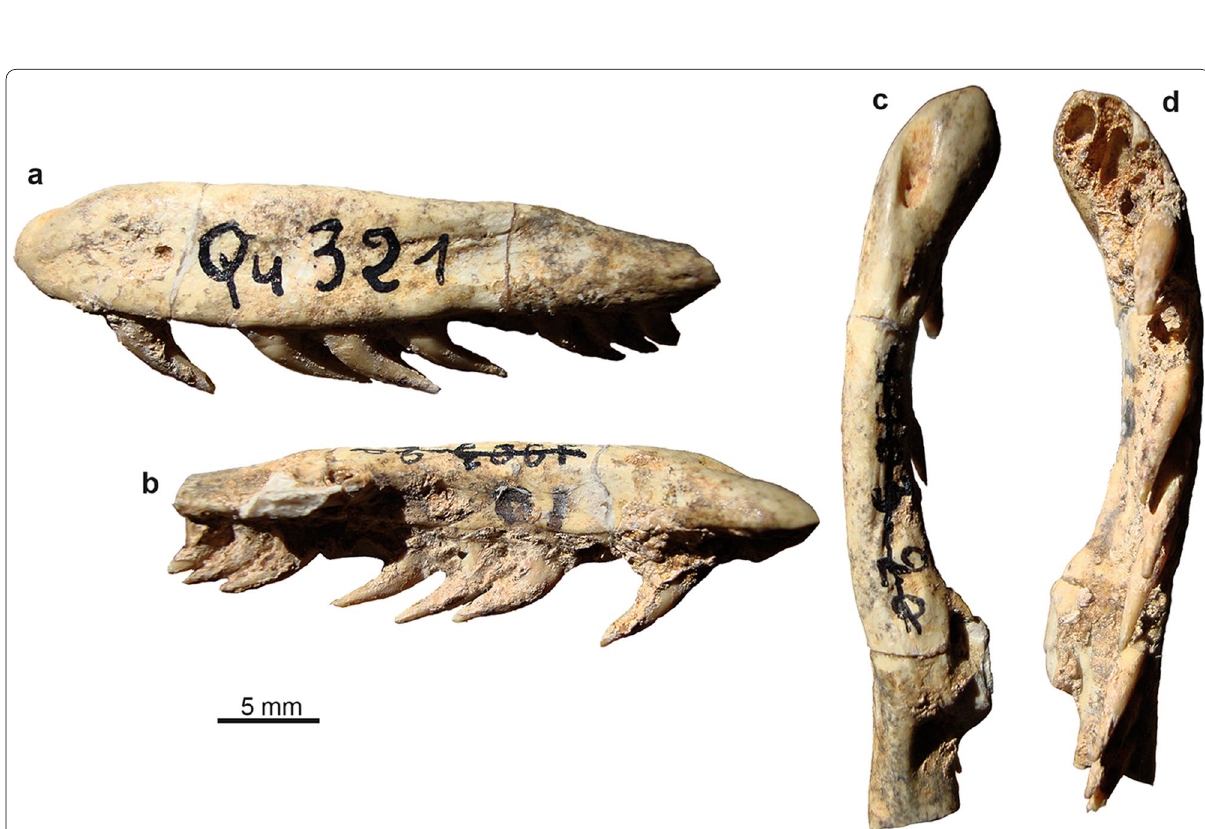
Fig. 5 Palaeopython cadurcensis from an imprecisely known locality in the Phosphorites du Quercy, paralectotype: left maxilla (MNHN.F QU16321) in labial ( a ), medial ( b ), dorsal ( c ), and ventral ( d )